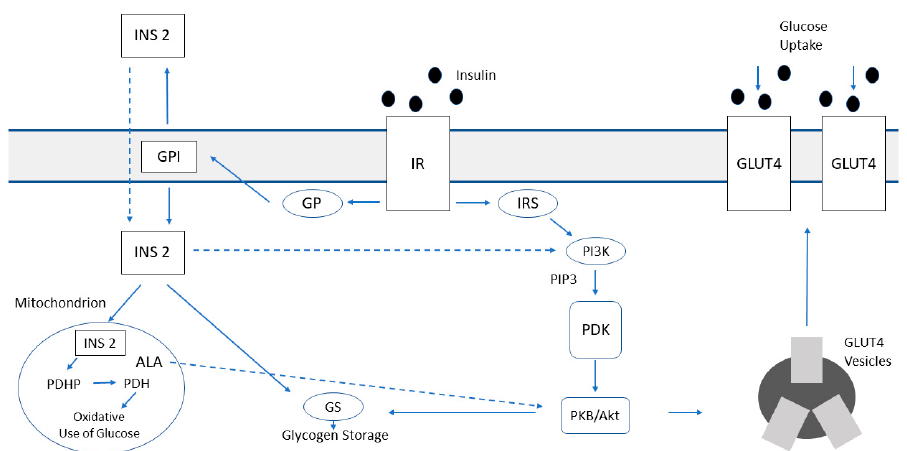
Figure 2. Representation of the role of inositols and alpha lipoic acid in insulin post-receptor signaling, modified from [17].